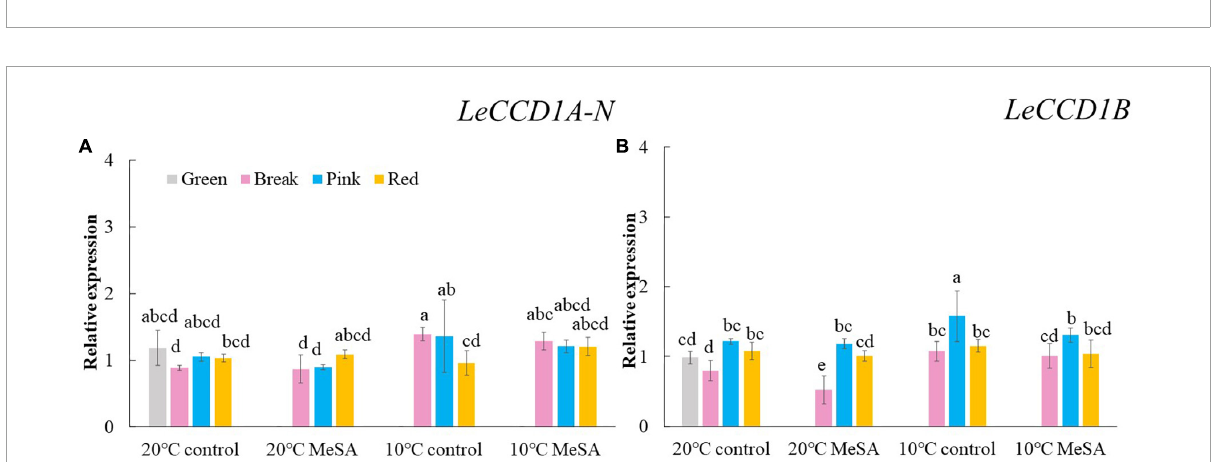
FIGURE5 Effects of methyl salicylate (MeSA) pre-treatment on the relative expressions of LeCCD1A-N (A) and LeCCD 1B (B) genes in tomato fruits stored at low temperature. Data are expressed as mean ± SD ( n = 3), repeated measures one-way ANOVA followed by DMRT. Data marked with the same letter were no significant difference at p < 0.05.